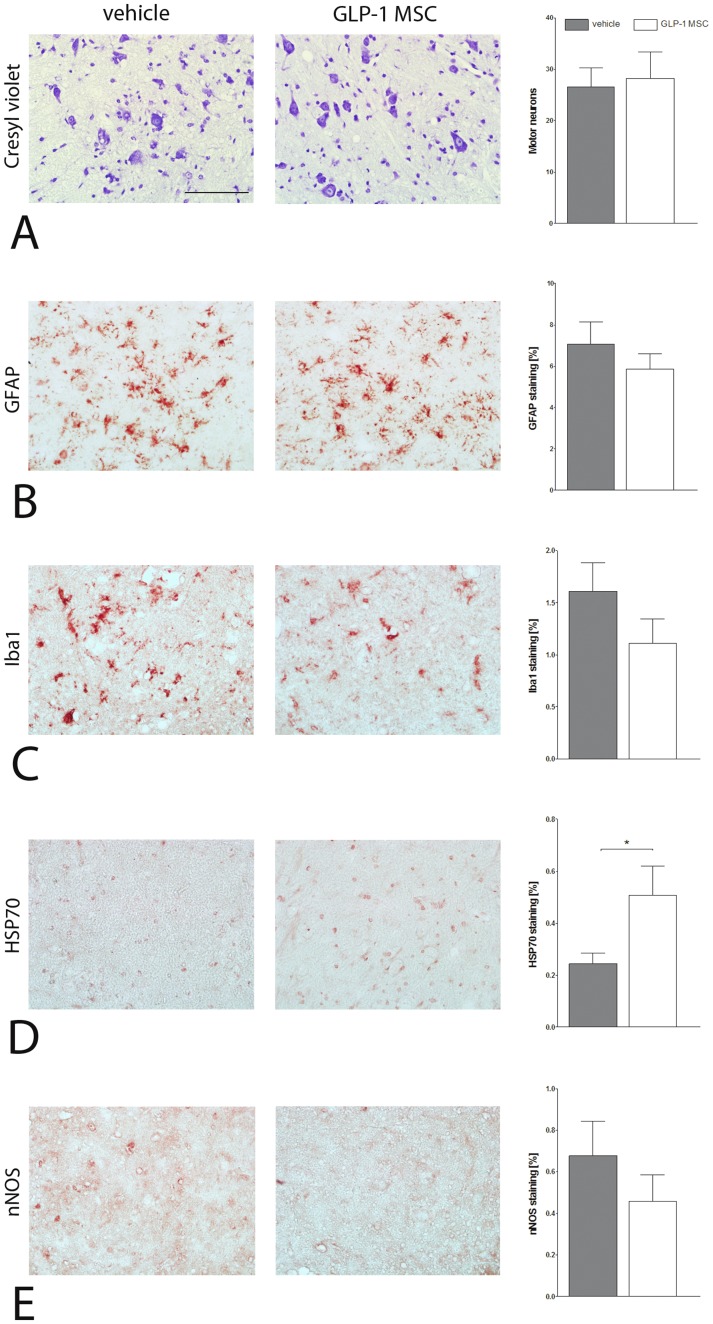
Immunohistological analysis of spinal cord tissue at day 110 of SOD1 (G93A) mice.(A) Motor neuron loss was not ameliorated by GLP-1 treatment (GLP-1 MSC) compared to vehicle treated controls (vehicle). (B) Astrocytosis (C) and microglial activation were marginally less in GLP-1 treated animals compared to controls. (D) Heat shock response was significantly increased by GLP-1 treatment and nNOS (E) was reduced slightly in these animals. Unpaired t-test. (*) p<0.05. Scale bar 100 µm.